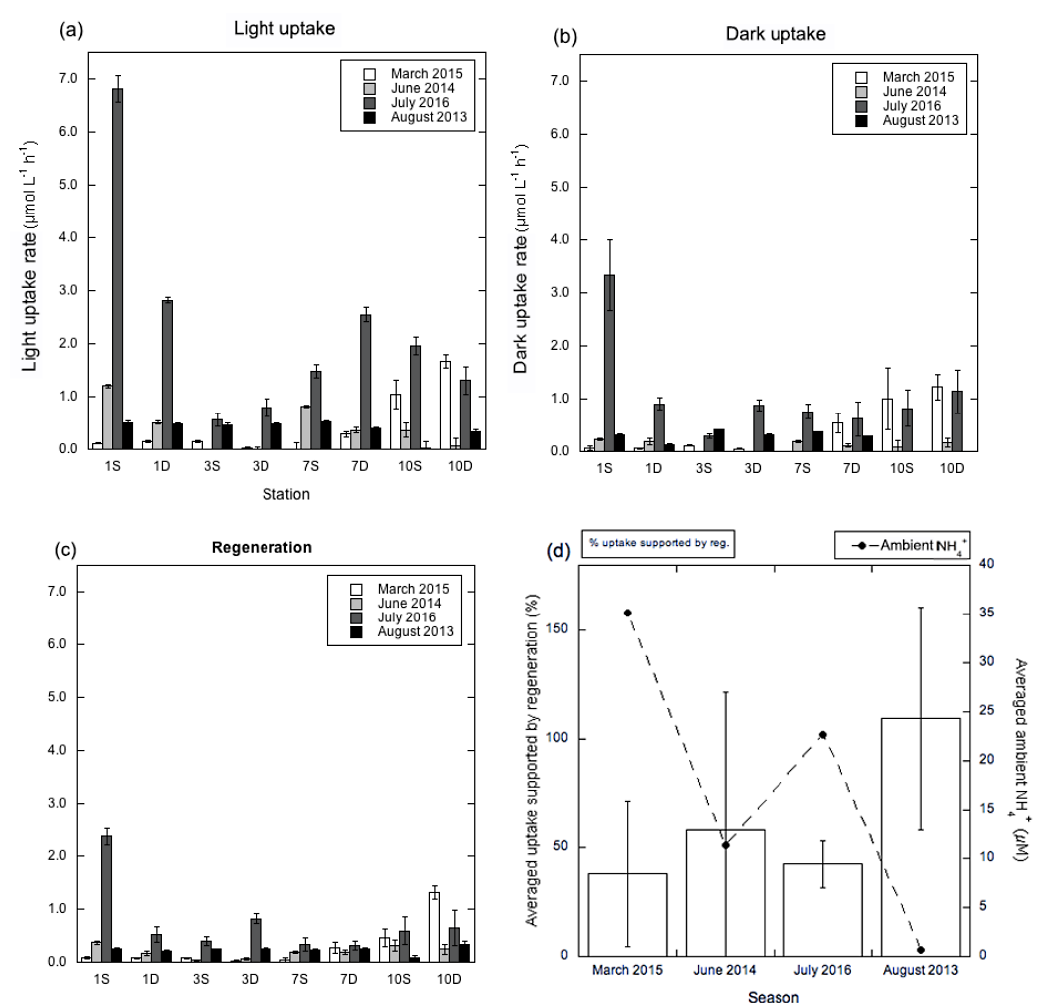
Figure 2. Ammonium dynamics in Taihu Lake. (a) Potential light uptake rates ± 1 standard error. (b) Potential dark uptake rates ± 1 standard error. (c) Mean light and dark regeneration rates ± 1 standard error. (d) Seasonal averaged percent of light uptake supported by regeneration ± 1 standard error and averaged in situ NH + 4